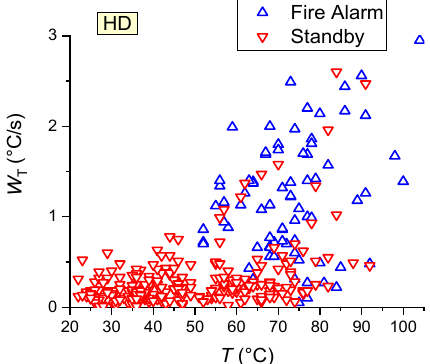
Figure 17. Summary map of HD activation/activation failure (all the results obtained during wood, linoleum, paper and cardboard combustion were used).